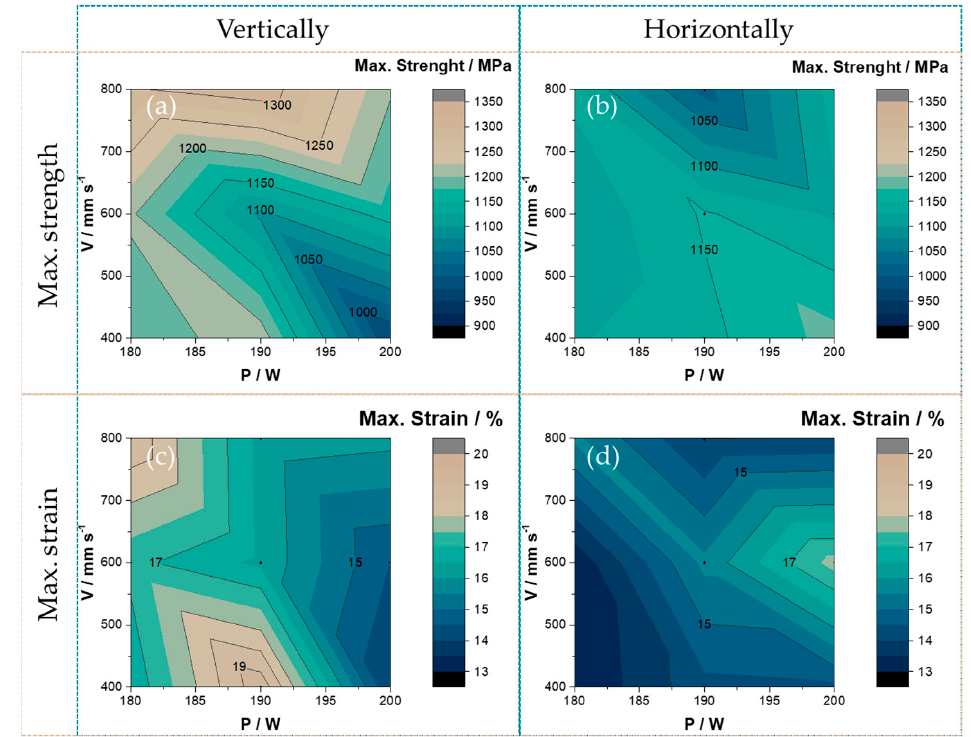
Figure 8. Summary of maximum strength and strain extracted from compression test as a function of laser parameters. ( a , c ) Vertically and ( b , d ) horizontally samples.